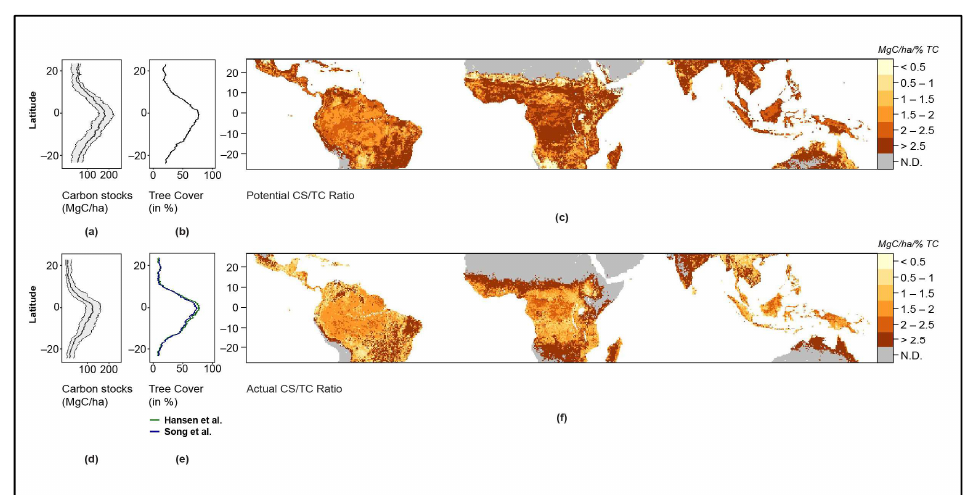
Figure 1. Biomass carbon stocks and tree cover across the tropics. ( a ) Latitudinal profile for potential CS with median and min–max envelopes. ( b ) Latitudinal profile for potential TC. ( c ) The CS/TC Ratio in the potential vegetation. ( d ) Latitudinal profile for actual CS with median and min–max envelopes. ( e ) Latitudinal profiles for both the actual TC maps used in the analysis, Hansen et al. (in green) and Song et al. (in blue). ( f ) The CS/TC Ratio in the actual vegetation. The maps are constructed using the potential TC map, for which only one dataset was available, and the pixel-based median of actual CS, potential CS and actual TC. For details and sources of maps, refer to Materials and Methods Section.